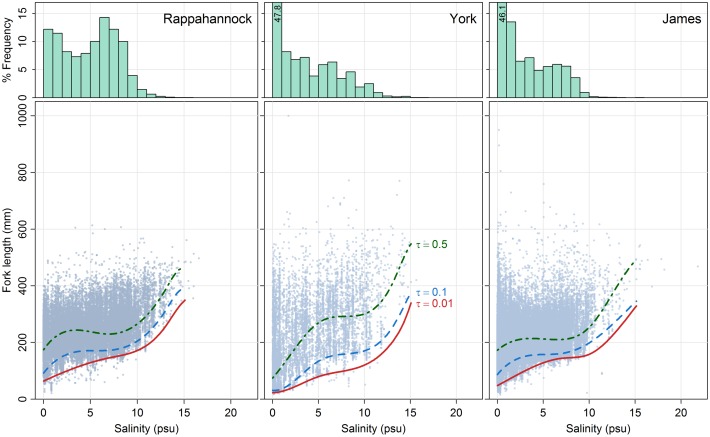
Bottom salinity and fork length of invasive blue catfish captured from the Rappahannock, York and James river subestuaries of the Chesapeake Bay during 1975–2017 by the VIMS juvenile fish trawl survey.The quantile regression splines for salinity ≤ 15 psu are shown for three quantiles (ε = {0.01, 0.1, 0.5}). Note that the y axis of the histogram is truncated for the York and James rivers; the percent of blue catfish captured at salinities < 1 psu in the York (47.8%) and James (46.1%) rivers are indicated in the figure.